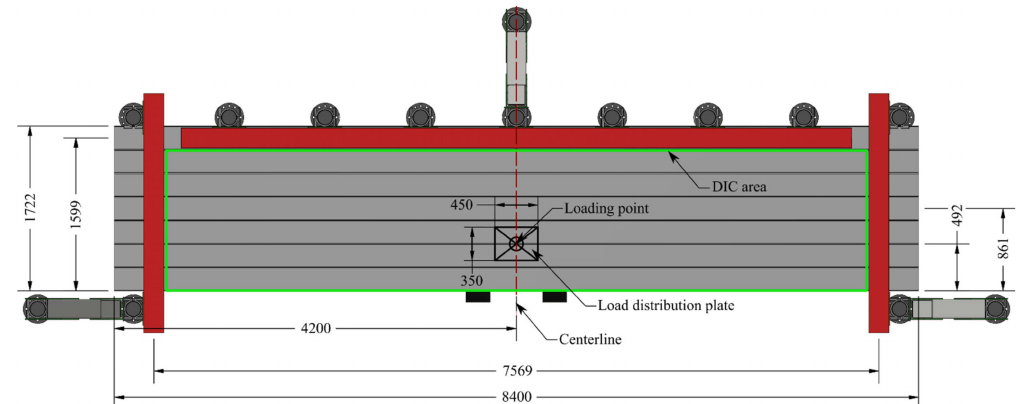
Figure 4. DIC coverage and loading point. All units in